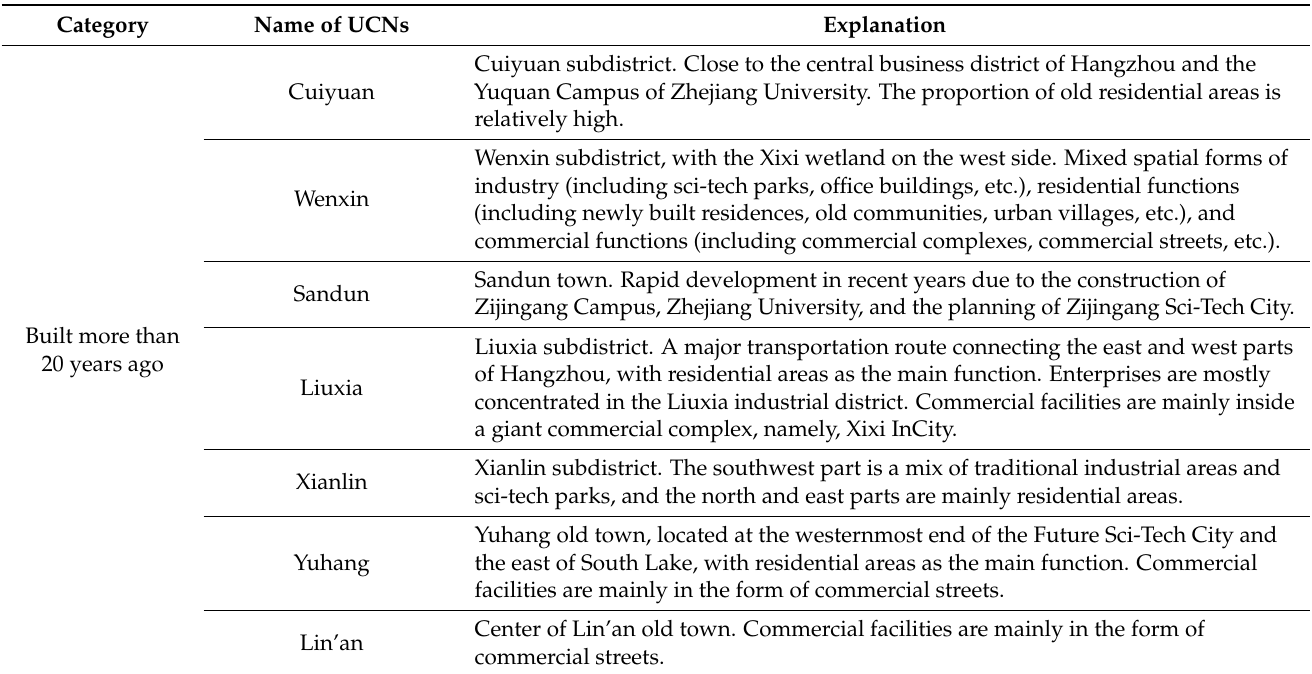
Table 3. Detailed information of